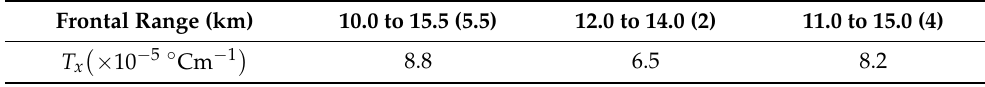
Table 1. The effect of frontal area definition on T x .